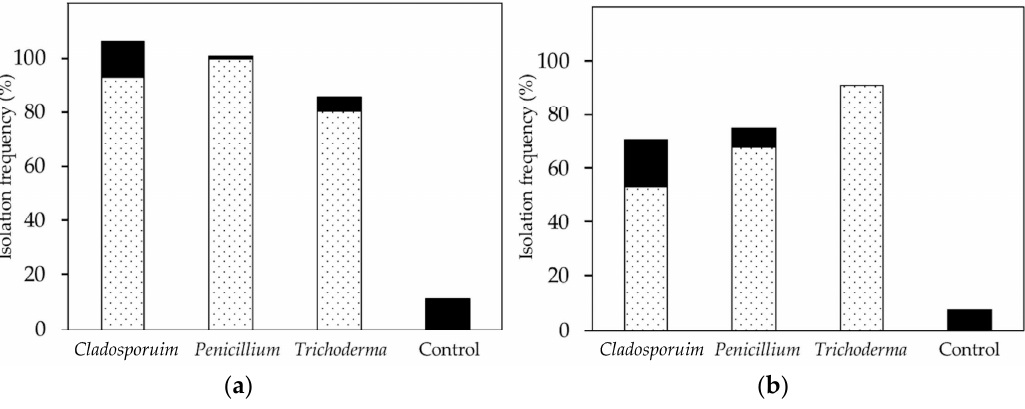
Figure 9. Results of culturing after in vivo inoculation. Dotted: reisolated fungi from inoculation trials, black: strains apparently present in the greenhouse. ( a ) Day of inoculation (i.e., day 0), isolation frequency higher than 100% because some discs yielded more than one isolate; ( b ) 14 DAI .